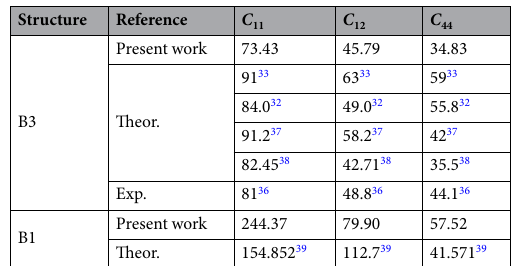
Table 2. The obtained elastic constants of ZnSe compared with other results.